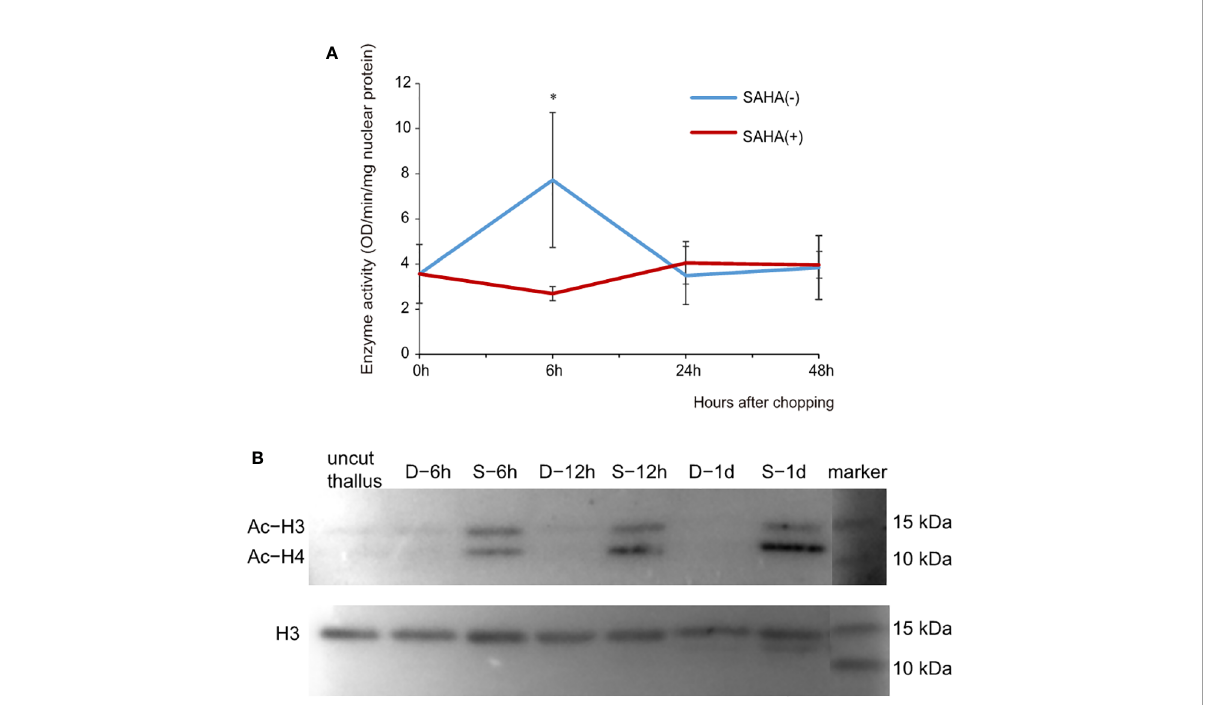
FIGURE 2 Effects of SAHA on the enzymatic activity of HDAC and acetylation levels of histone proteins in thallus fragments after wounding. (A) Changes of HDAC activities in cut fragments in control or SAHA-supplemented media. Error bars represent the SD (n = 3). *, 0.01 < P-value < 0.05. (B) Immunoblot of acetylated (Ac) histone H3 and H4 in cut fragments in control (marked as D-) or SAHA-supplemented media (marked as S-). Simultaneous staining of total histone H3 was used as internal